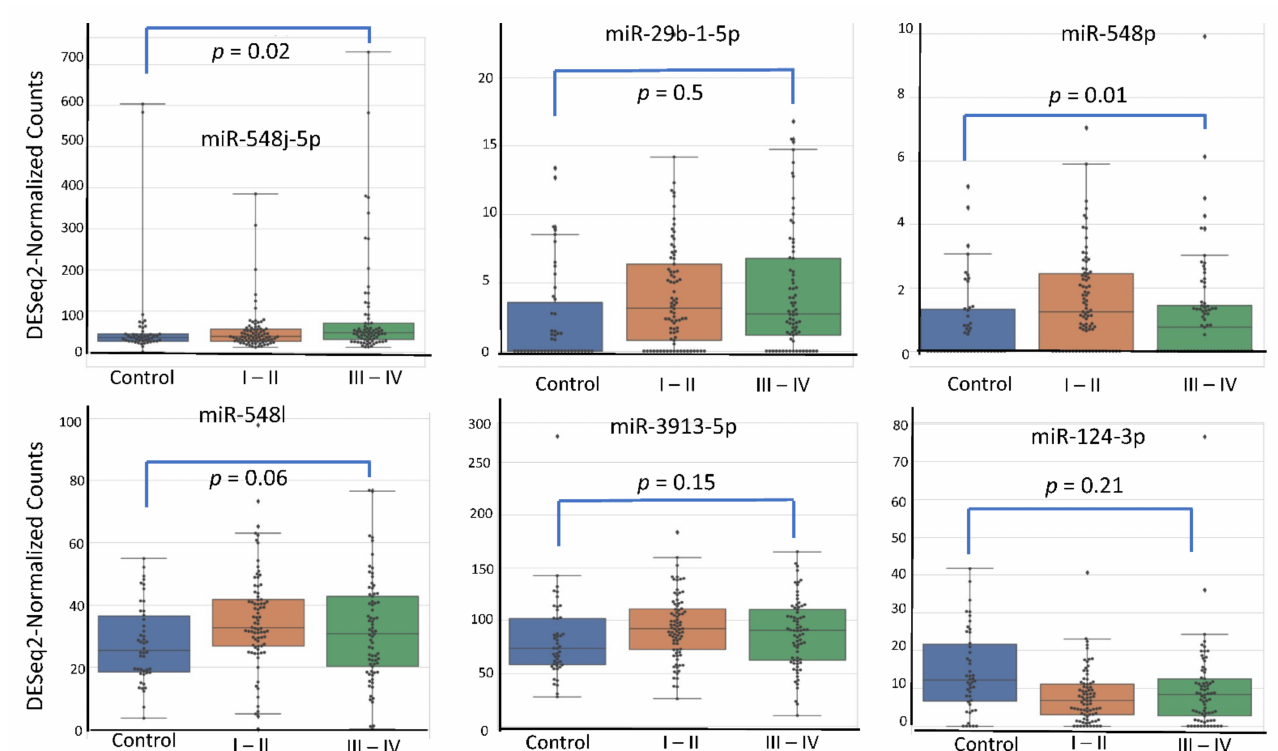
Figure 1. miRNA serum expression according to endometriosis